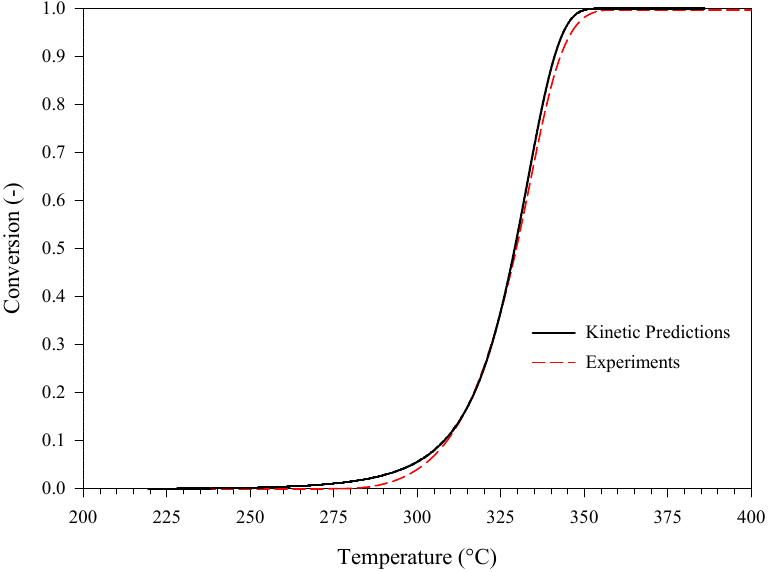
Figure 7. The conversion of PA as a function of temperature at a heating rate of 40 °C min − 1 : DSC experiments (mean data, dashed line) and corresponding kinetic predictions (solid line).